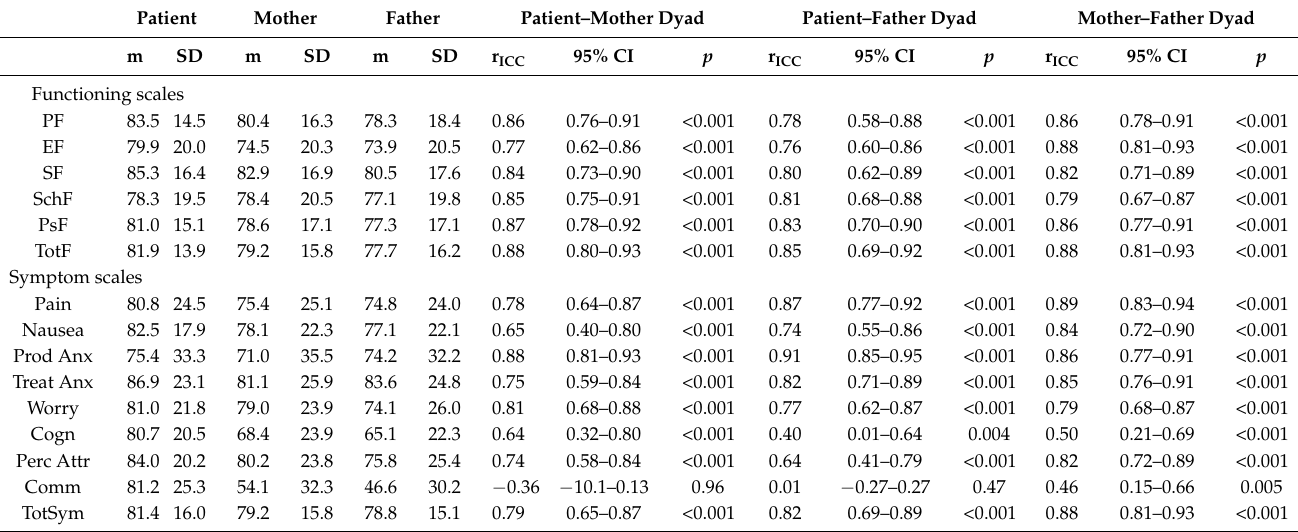
Table 6. Associations of the children’s self-report and parental proxy ratings after rehabilitation (T1), stratified by patient–mother and patient–father dyads.